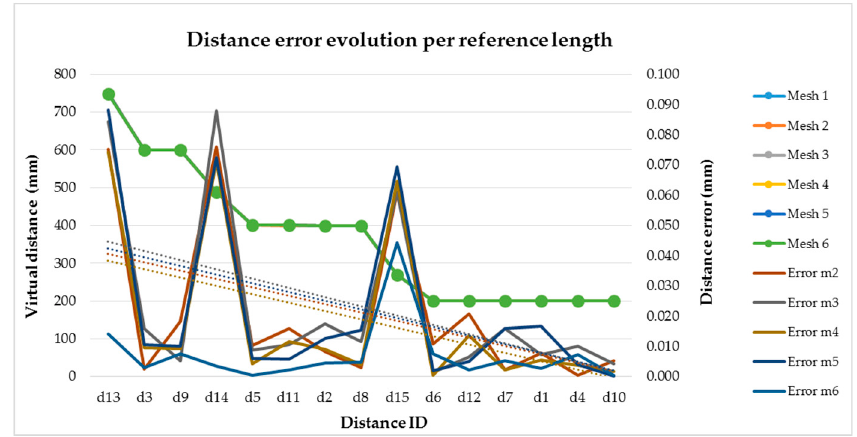
Figure 10. Distance error per virtual distance evaluated (evaluation method 4).